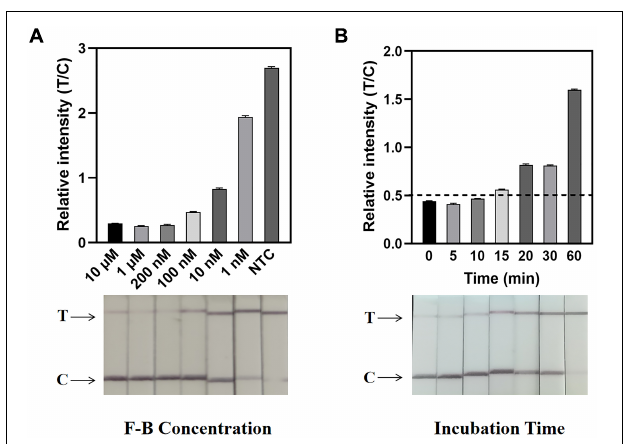
FIGURE 4 | Determination of F-B concentration and reaction time by the ERA/CRISPR–Cas12a dipstick system. (A) Concentration optimization of the dipstick probe (F-B). The relative intensities of the band are shown at the top, and the dipstick results for different F-B concentrations are shown below. (B) An optimal incubation time of the CRISPR–Cas12a system. The black horizontal dashed line in the gray scan indicates the cutoff value set based on T/C values of the negative control. Error bars in panels represent the mean ± SD, where n = 3